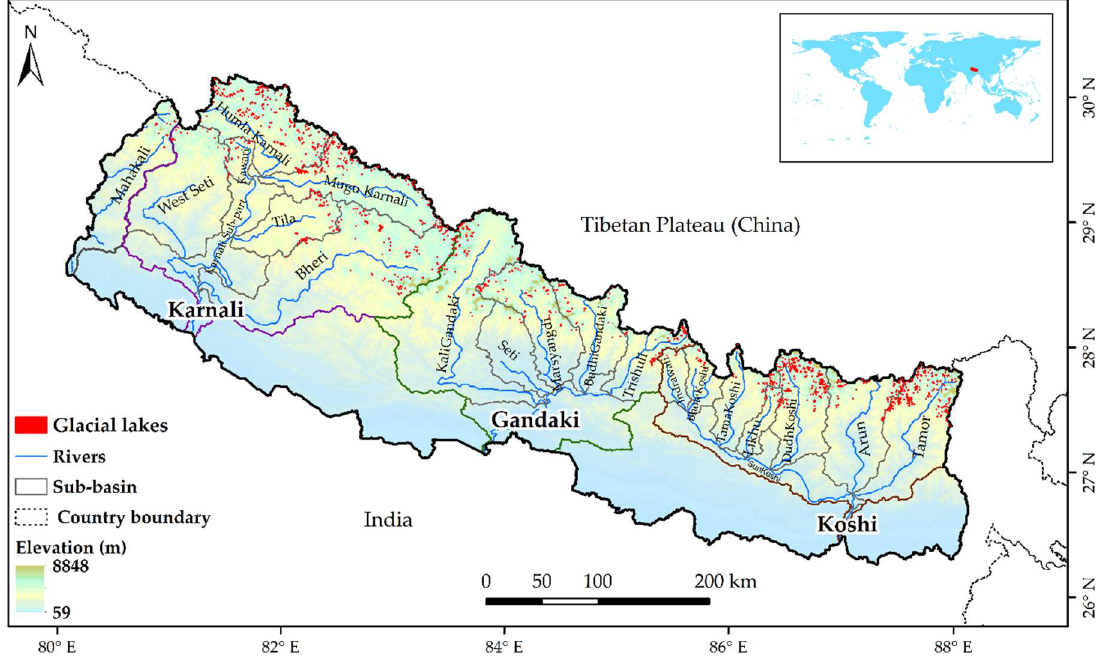
Figure 1. Location of the study area: The Nepal Himalaya. The inset map shows the position (with red mark) of Nepal in the globe. The sub-basins are named after the main rivers draining into them. The distribution of glacial lakes (2017) across the Nepal Himalaya is also presented in the map.